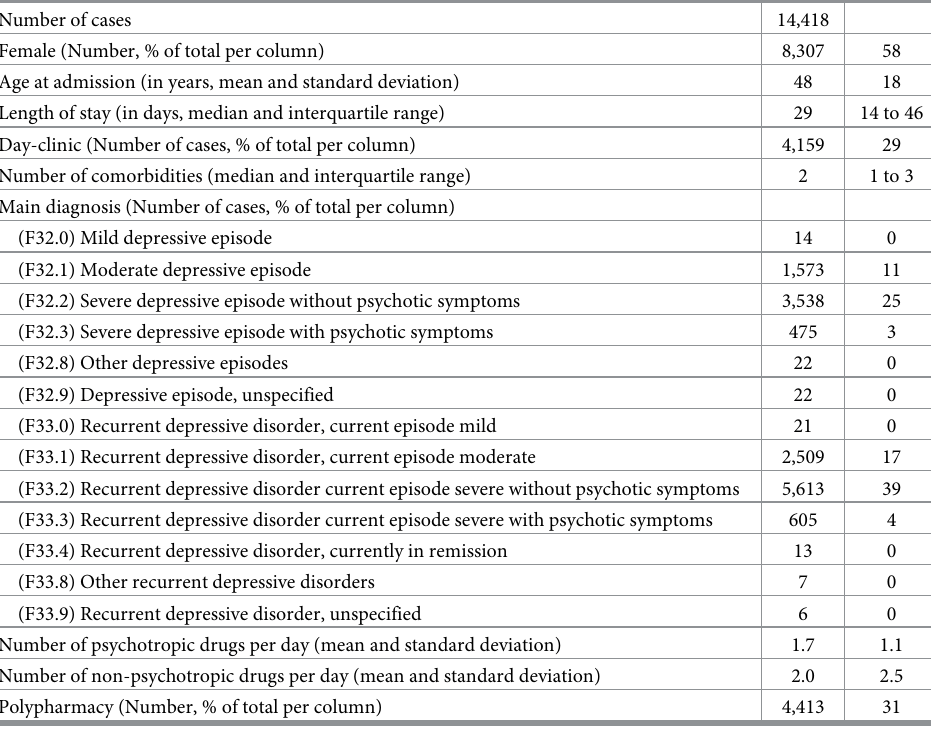
antidepressants were selective serotonin reuptake inhibitors (SSRI), followed by serotonin and norepinephrine reuptake inhibitors (SNRI) and tetracyclic antidepressants (Fig 1B). SSRI were the drug class which was most frequently used for monotherapy (12% of inpatient days, Fig 1A). The most frequent augmentation therapy was SSRI augmented by atypical antipsychotics, followed by SNRI augmented by atypical antipsychotics. The most frequent combinations of antidepressants were SSRI in combination with tetracyclic antidepressants and SNRI in com- bination with the tetracyclic antidepressant mirtazapine. Fig 1 shows only drug combinations that accounted for at least 2% of total patient days. Lithium did not reach that threshold. In total, 2.8% of patients received Lithium alone or in combination with other drugs for at least one day. Table 2 shows the determinants of receiving different antidepressant and antipsychotic drug regimes. Cases with moderate depression and cases with depressive episodes (F32) were more likely to receive neither antidepressant nor antipsychotic drug treatment and more likely to receive a monotherapy with antidepressants. Cases with recurrent depressive disorders and cases with severe depression were more likely to receive a combination of multiple antidepres- sant drugs. Cases with a high severity of disease measured by the CGI-scale at both admission and discharge were more likely to have switched between different antidepressant or antipsy- chotic drugs.